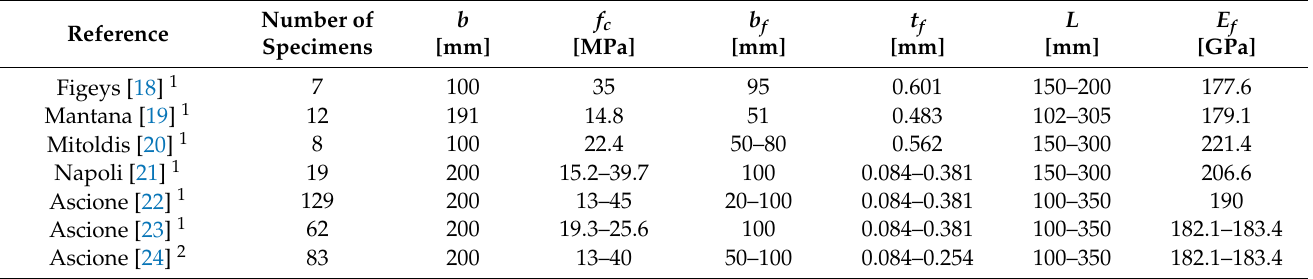
Table 2. List of geometry and material properties collected from the available experimental